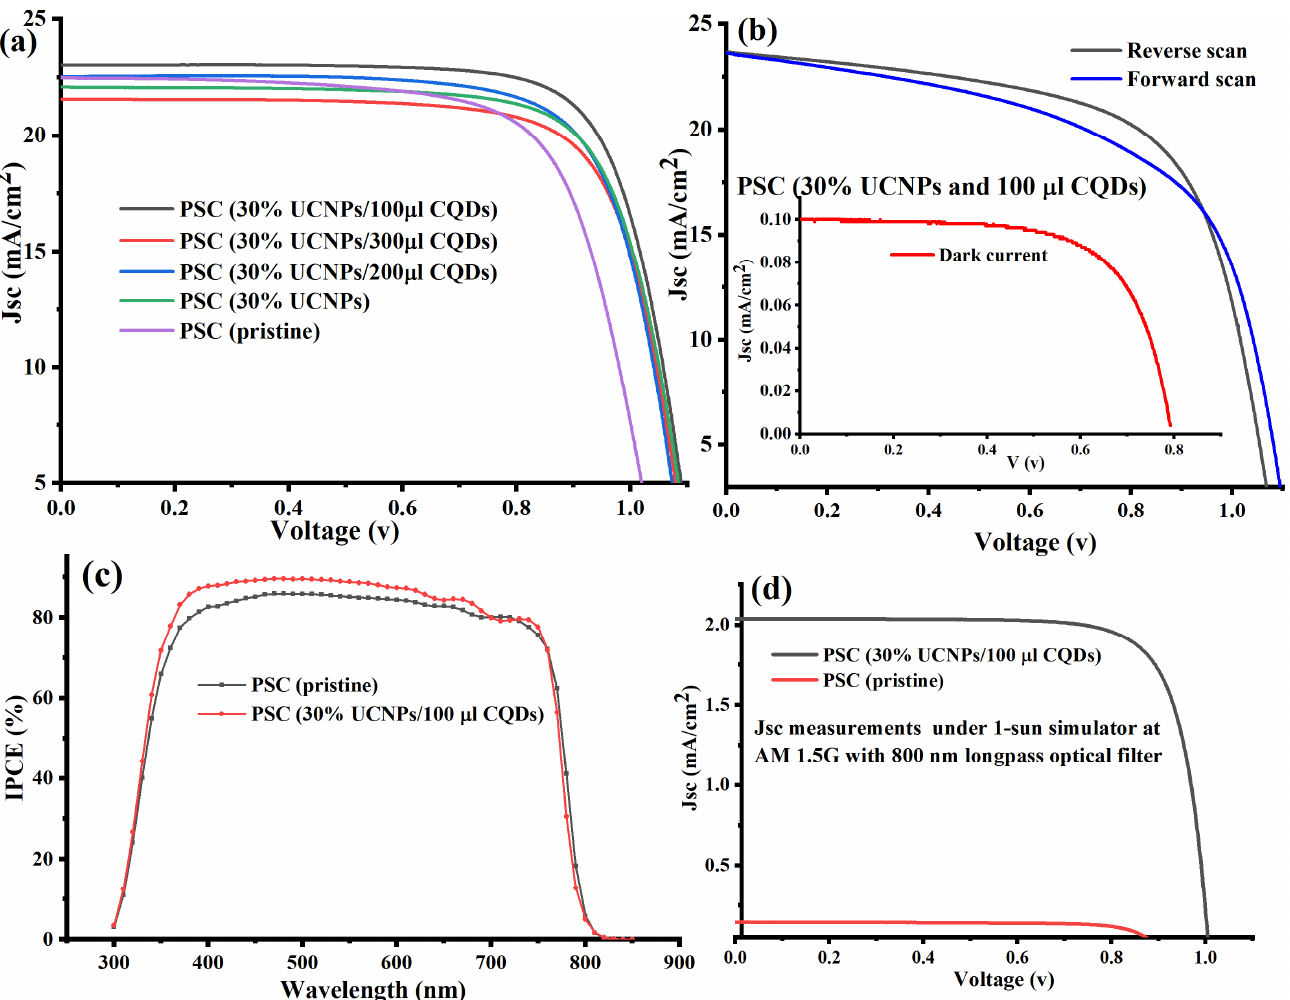
Figure 4. ( a ) J–V characteristic curves for PSCs with and without UCNP and CQD levels integrated inside the mesoporous and perovskite layers, as measured under AM 1.5 G. ( b ) Reverse and forward scans of the (J–V) curves of the best fabricated device (PSC device (30% UCNPs and 100 µL CQDs)). (( b ) inset) Dark-current measure for the PSC device (30% UCNPs and 100 µL CQDs). ( c ) Quantum efficiency (IPCE) spectra of the PSC device (30% UCNPs and 100 µL CQDs) and the pristine device. ( d ) J–V characteristics measured under NIR irradiation with an 800 nm long-pass filter for the PSC device (30% UCNPs and 100 µL CQDs) and the pristine device.